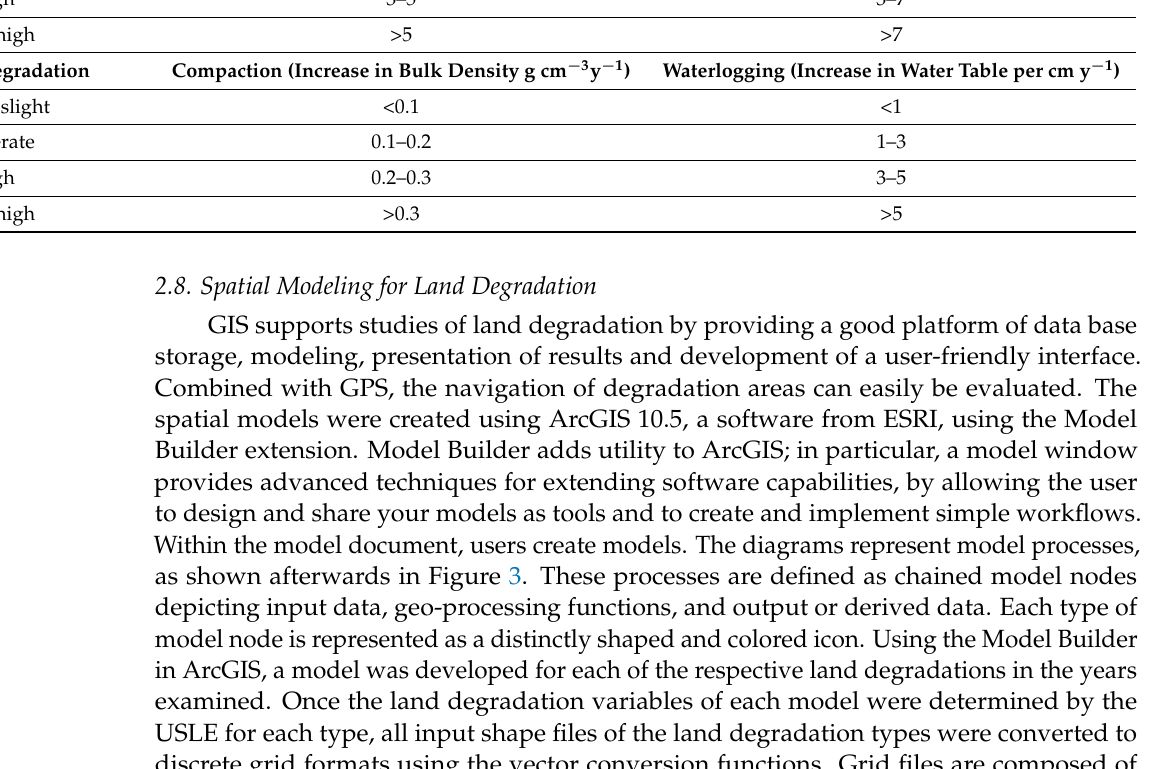
Table 3. Criteria used to determine the classes and rates of different types of degradation after FAO/UNEP